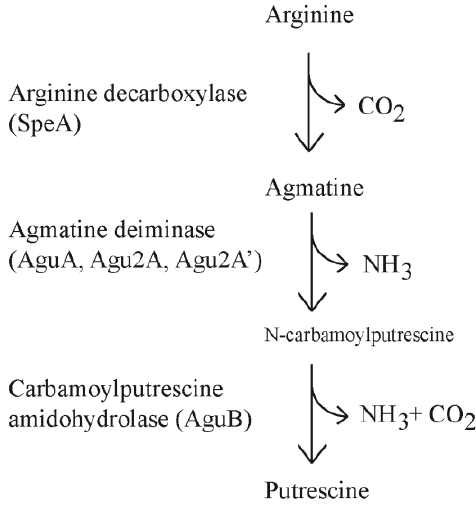
Figure 1. The arginine decarboxylase and agmatine deiminase